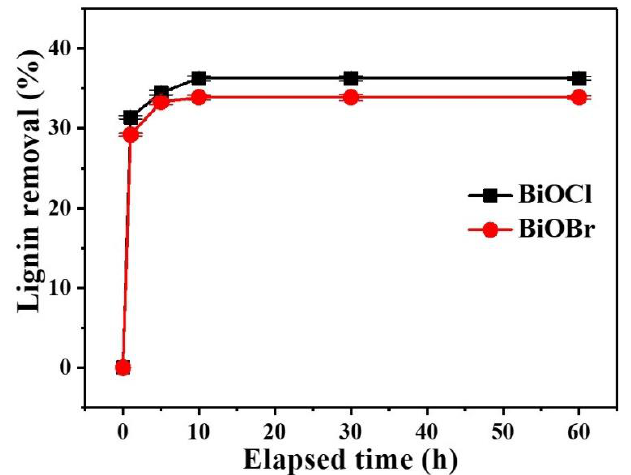
Figure 2. Effect of elapsed time on the lignin removal of PHL by BiOCl/BiOBr treatment.